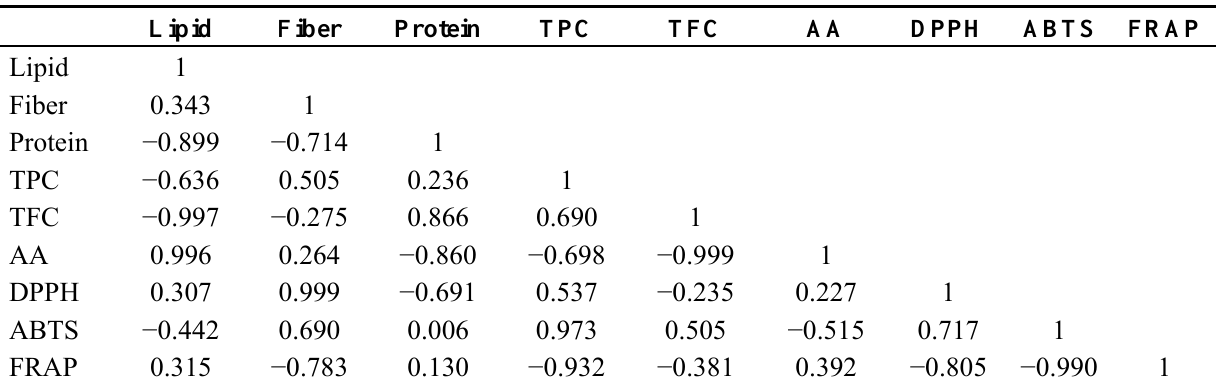
Table 2. Pearson correlation among chemical/antioxidant constituents and scavenging activities for leaves from three varieties of